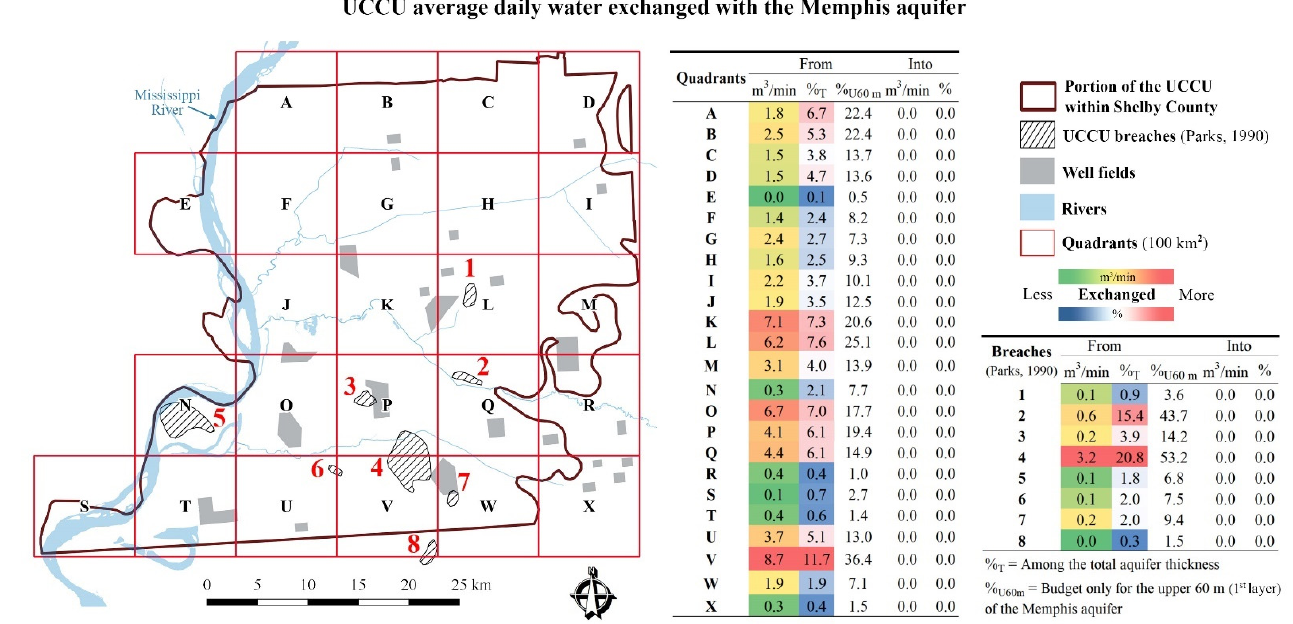
Figure 14. Average daily water exchanged only between the UCCU and the Memphis aquifer as leakage for August 2016 in Shelby County, using quadrants and breaches for focused analysis.